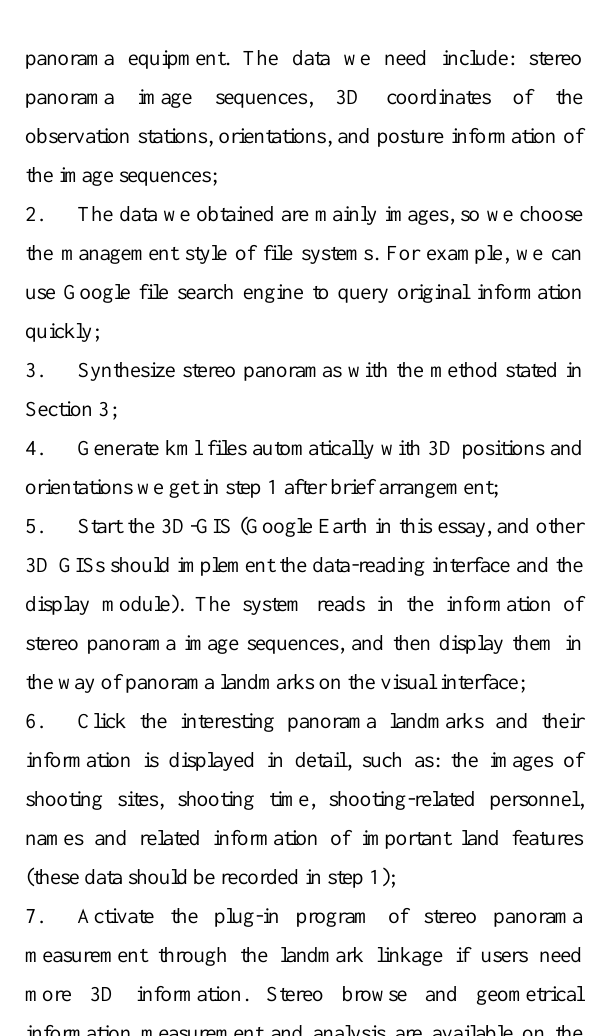
Figure 7. Workflow of building stereo